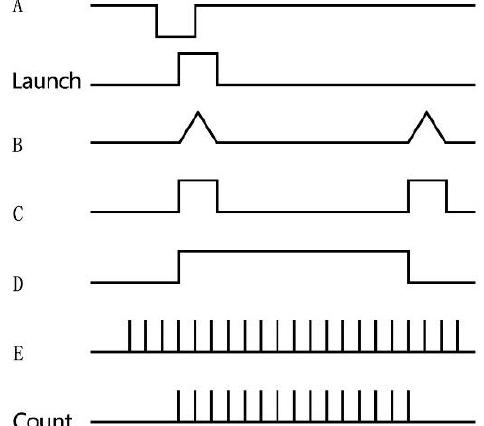
Figure 3. Waveform and timing diagram of the pulsed laser ranging system.